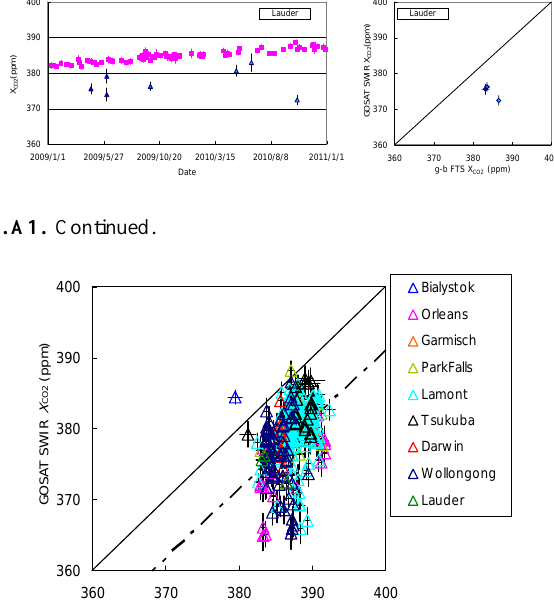
Fig.A3. 3 Fig. A2. Scatter diagram between GOSAT and g-b FTS X all FTS sites. The GOSAT data were retrieved within ± 2 degrees latitude/longitude box centered at each g-b FTS site and the g-b FTS data were the mean values measured within ± 1h of GOSAT overpass time.